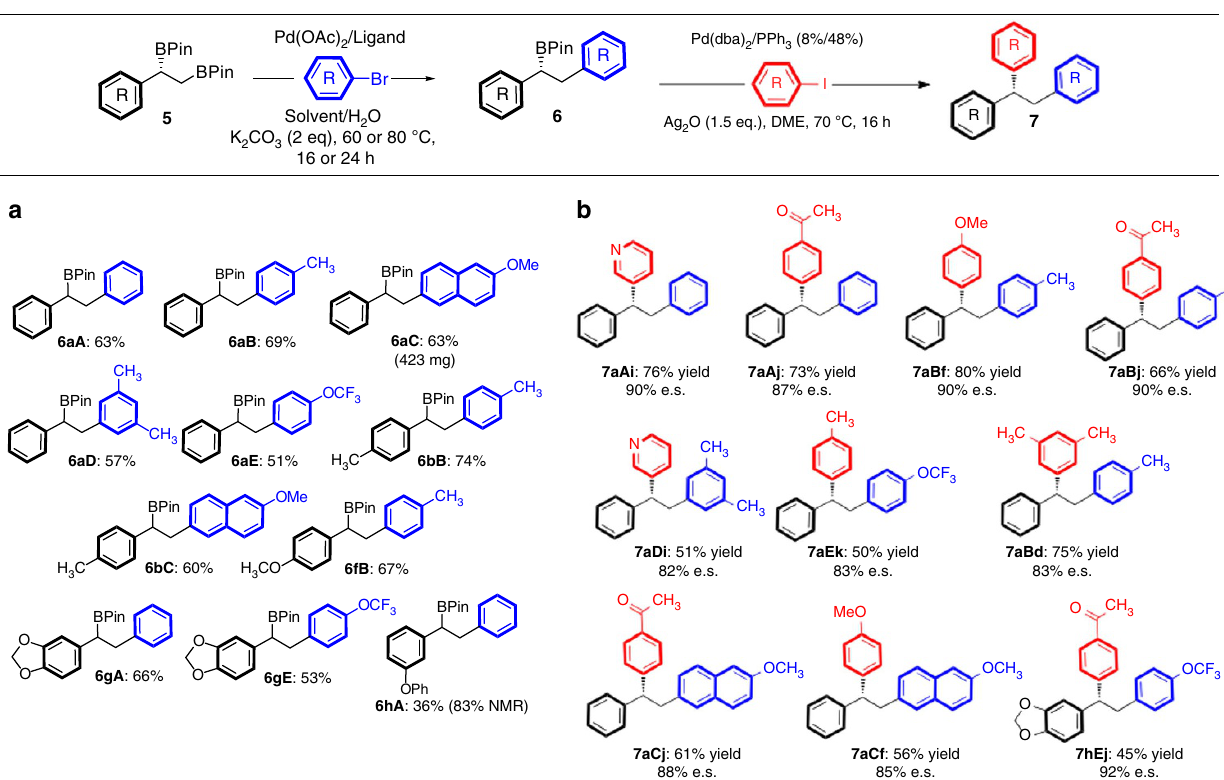
Figure 3 | Chemoselective Suzuki–Miyaura cross-coupling of chiral 1,2-diboronic esters. ( a ) Demonstration of selective coupling of linear boronic ester, while the branched B–C bond remains intact. ( b ) Stereoretentive coupling of remaining secondary benzylic B–C bond in enantioenriched boronic esters, leading to enantiomerically enriched unsymmetrical 1,1 0 ,2-triarylethanes with up to 92%